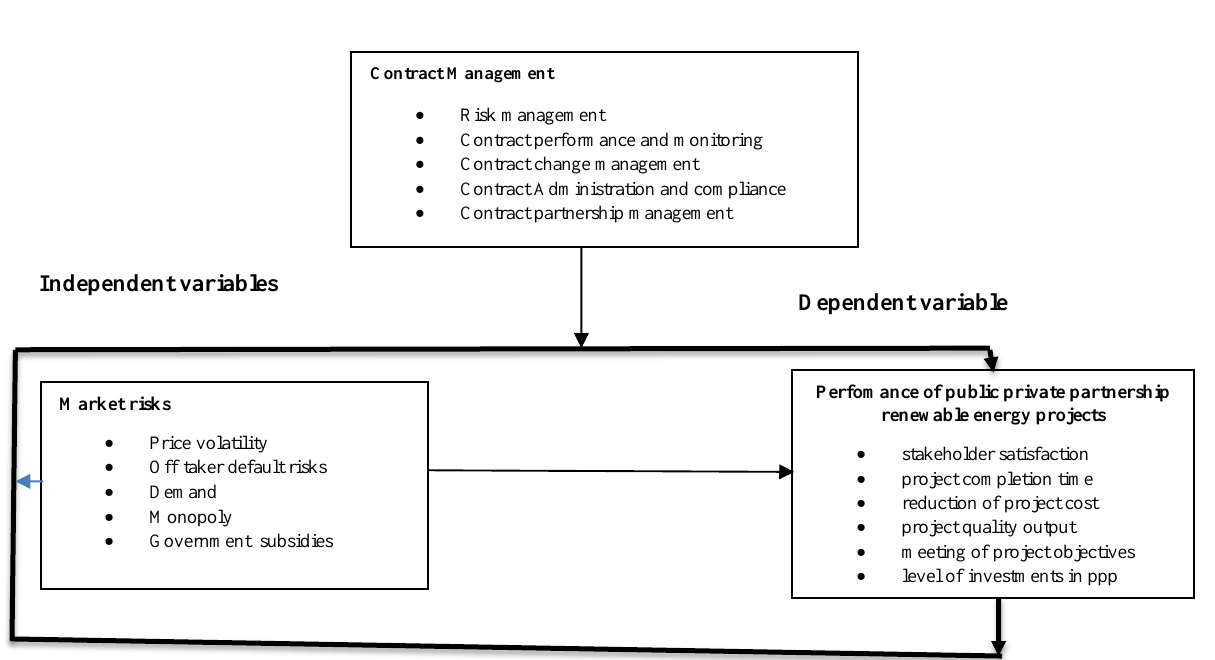
Figure 1: Conceptual Frame work for market risk factors, contract management and performance public private partnership